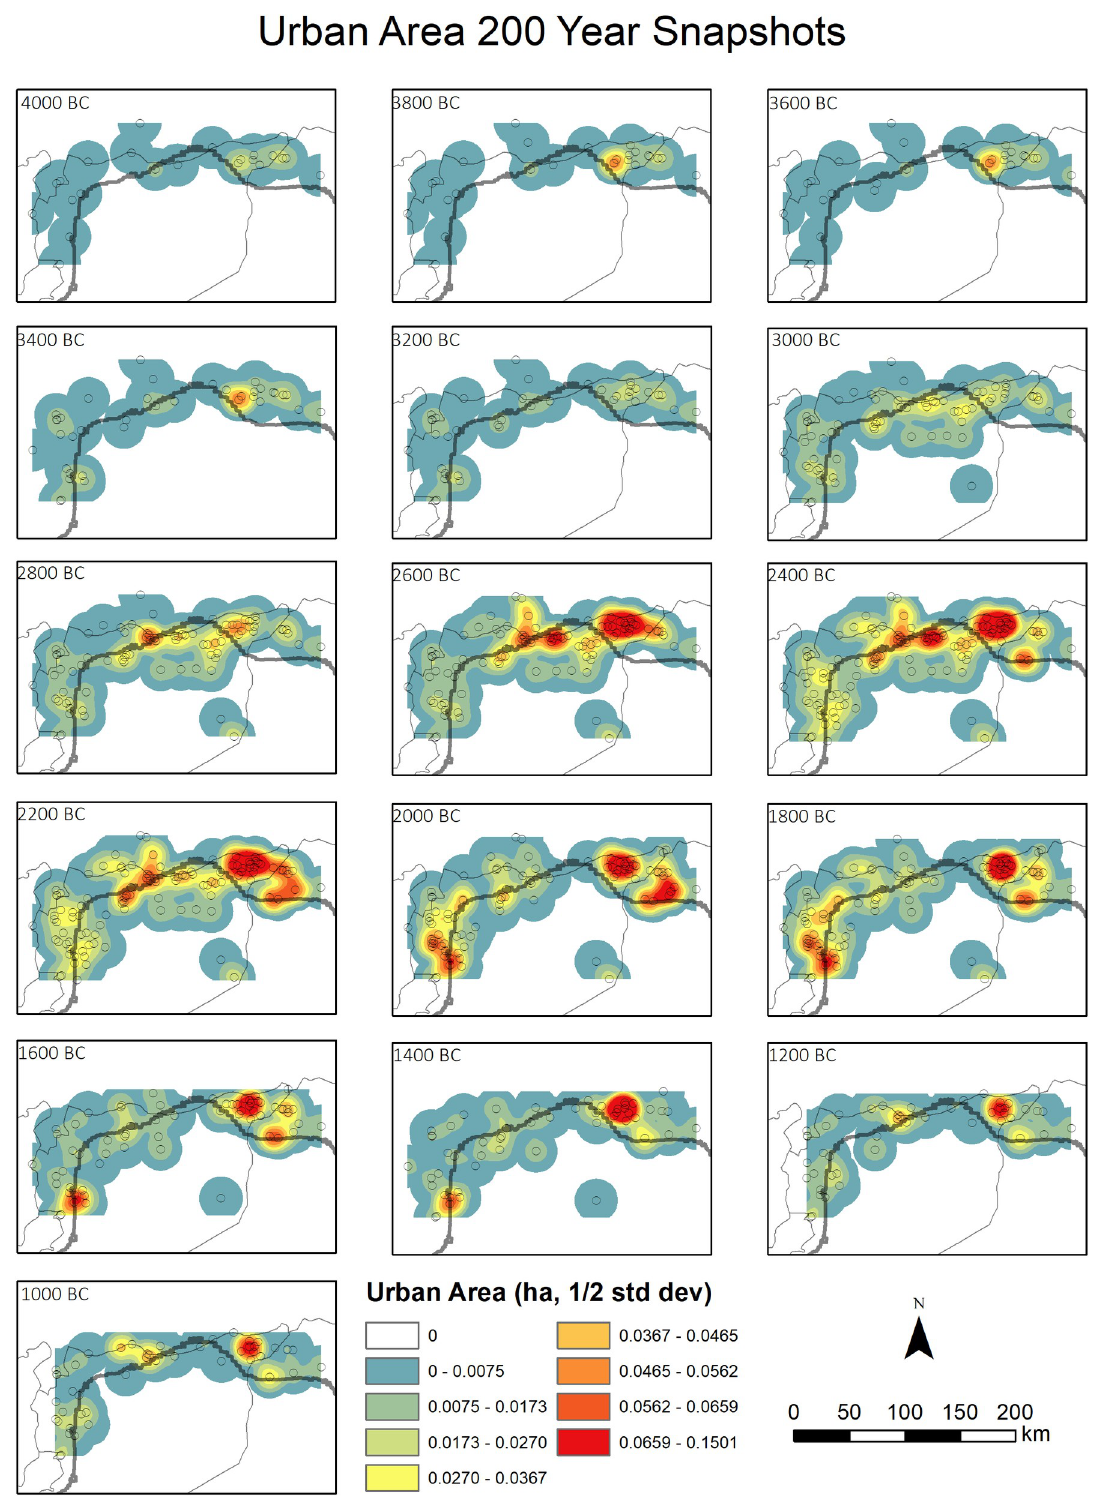
Fig 6. Urban settlement kernel density estimates. KDE bandwidth: 50km. Snap shot maps at 200-year intervals. Country outlines from the GADM website (https://gadm.org/).